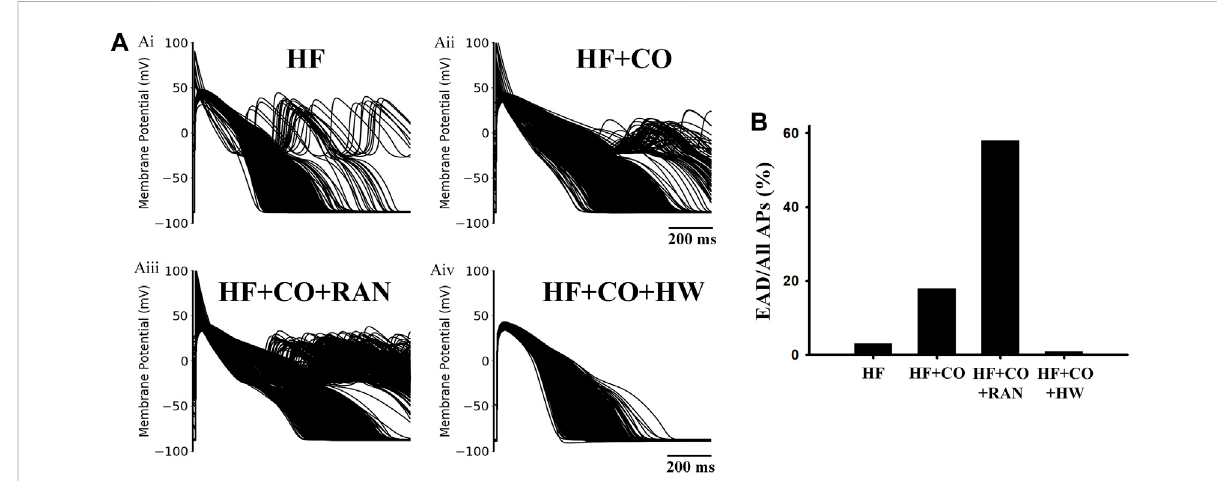
FIGURE 13 Population-basedmodelingforfourconditionsinheartfailurehumanventricularMIDcells. (A)